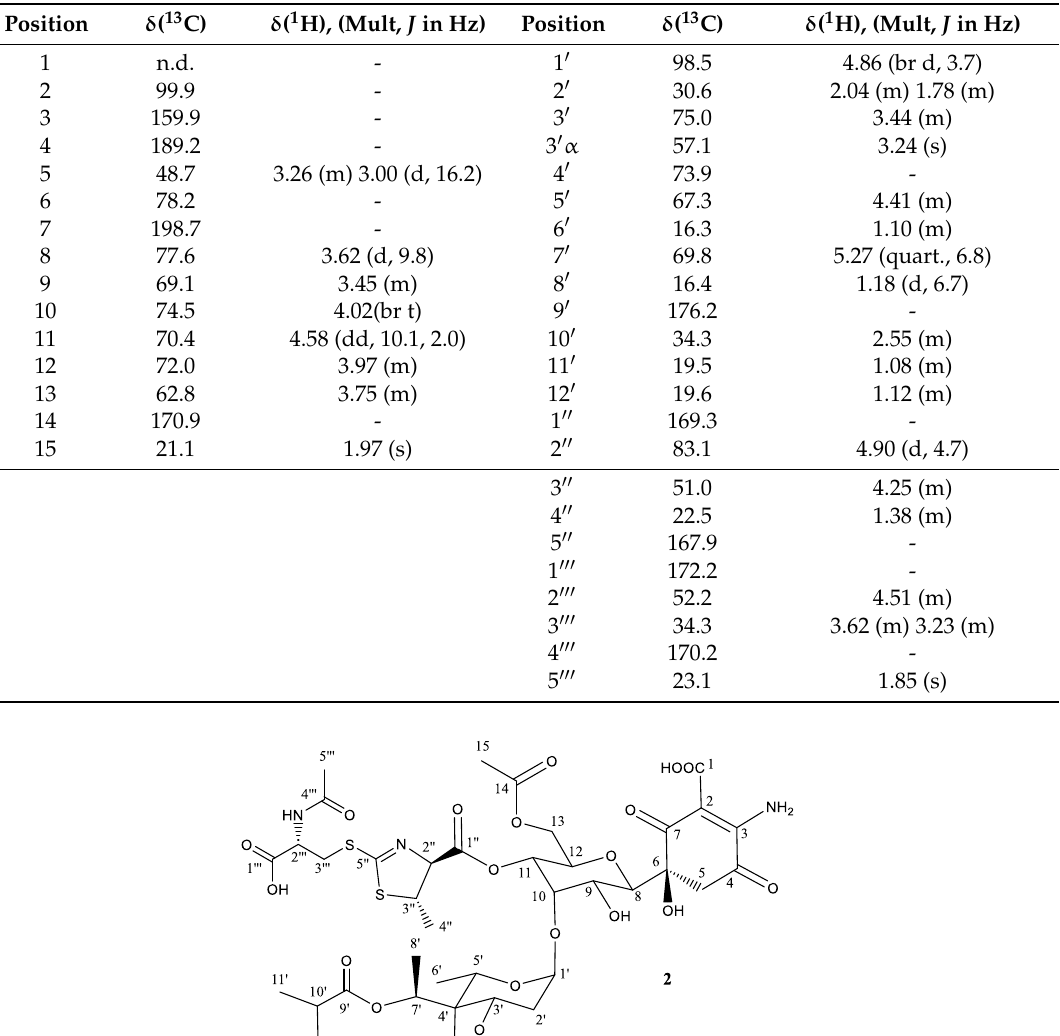
Table 2. NMR data ( 𝛅 in ppm) for compound 2 (DMSO- d 6 , 500 MHz, 24 °C). Carbon chemical shifts derived from HSQC and HMBC spectra.